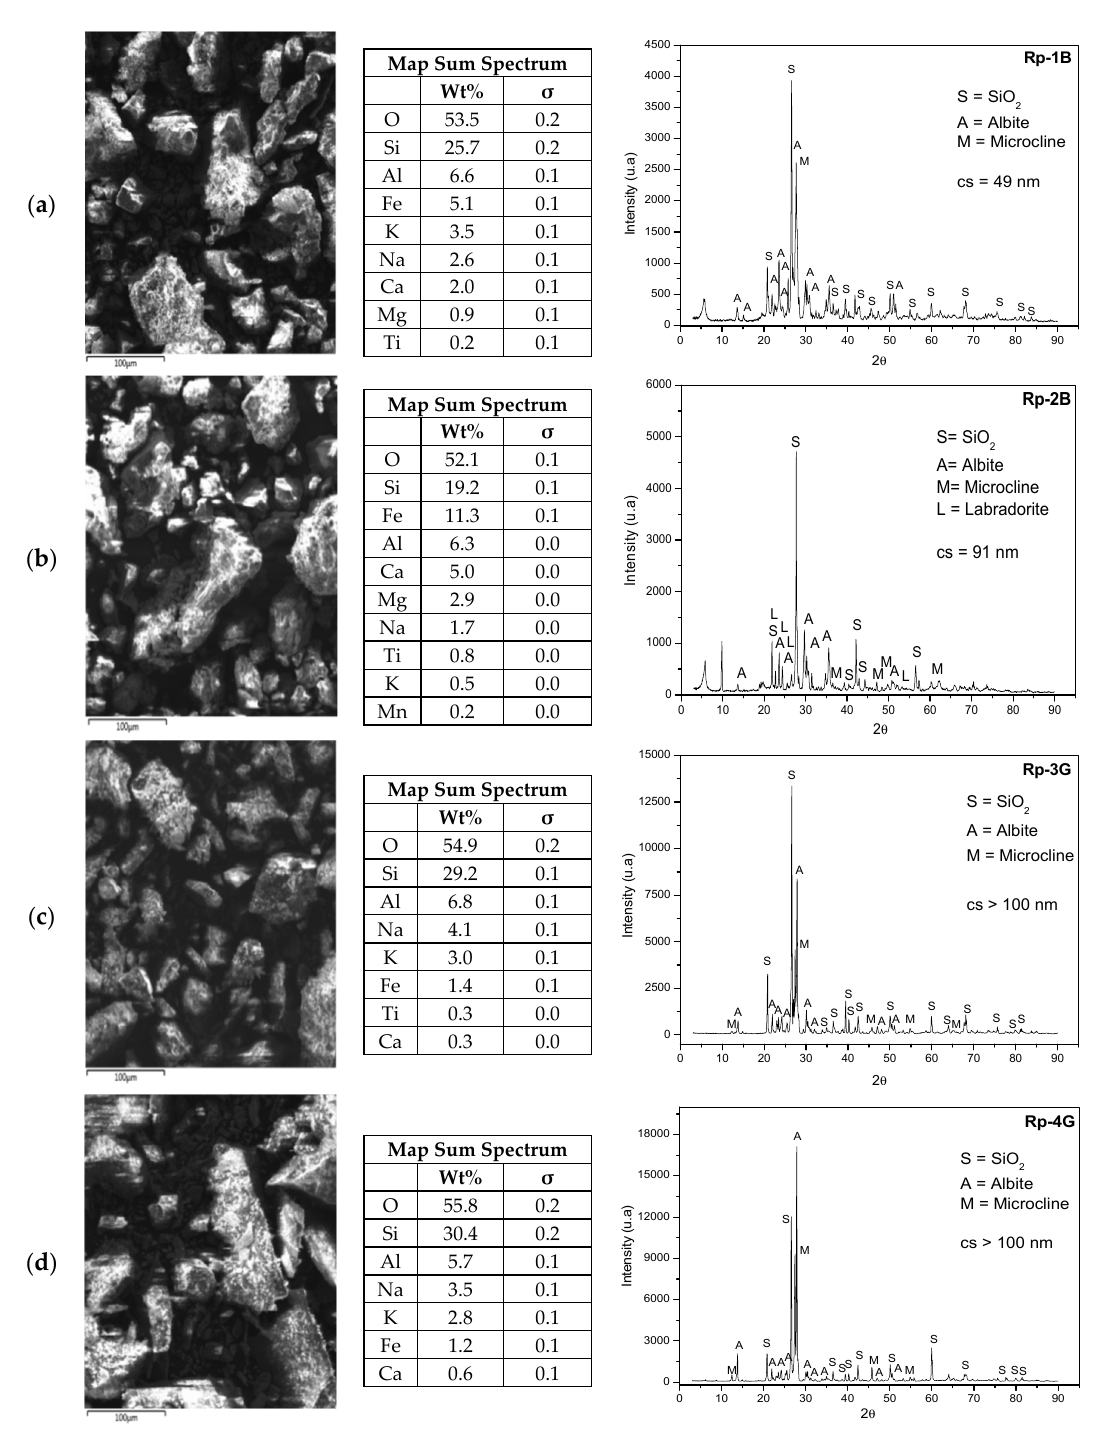
Figure 1. SEM-EDS and XRD (500×) results for each material studied: ( a ) Rp-1B, ( b ) Rp-2B, ( c ) Rp-3G, and ( d ) Rp-4G.